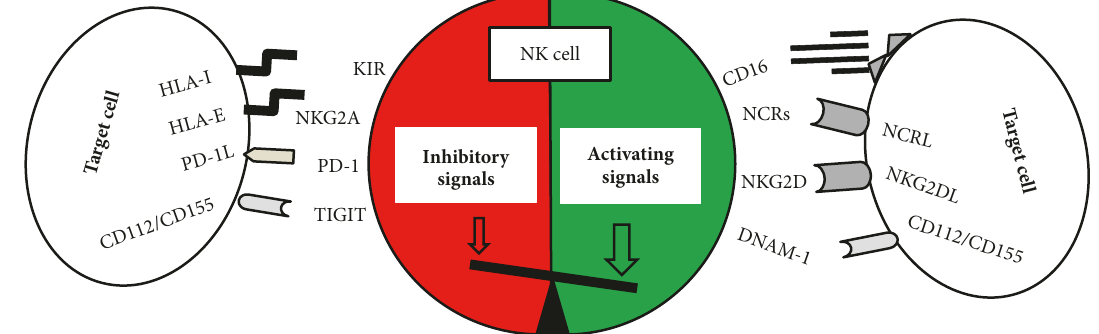
Figure 1: B alance o f inhibitory an d activating signals in NK cell activation . Inhibitory signals are mediated through receptors specific for human leukocyte antigen (HLA) class I molecules and other inhibitory receptors such as PD-1 (ligand PD-1L) and TIGIT (ligands CD155 and CD112). Activating signals are transmitted though several surface receptors that recognize ligands expressed on transformed cells. The balance between inhibitory and activating signals will determine NK cell activation and